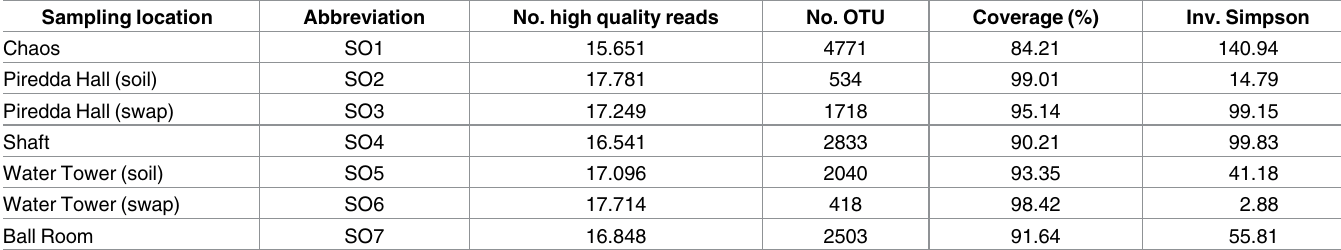
Table 3. Bacterial and archaeal16S rRNA gene diversity analyses of samples obtained from the Su Bentu Cave in Sardinia. Sampling location